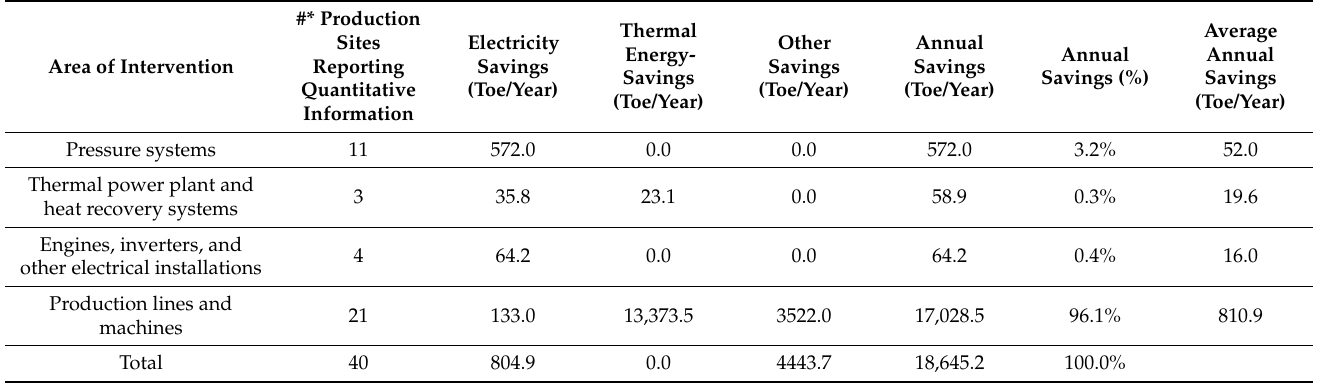
Table 4. Energy-savings produced by the implemented technological interventions. The total annual savings are calculated as the sum of thermal energy, electricity, and fuel savings.